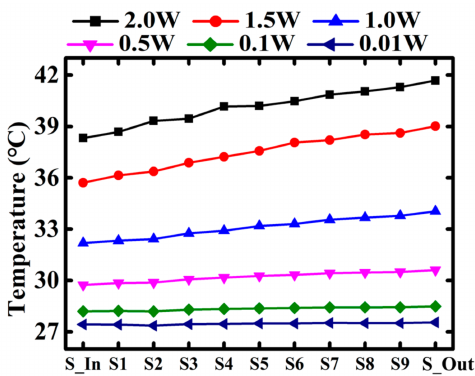
Figure 7. Under different heating power, the temperature profile in the micro-fluid channel from the inlet to outlet where corresponding the temperature sensors from S-In to S-Out.